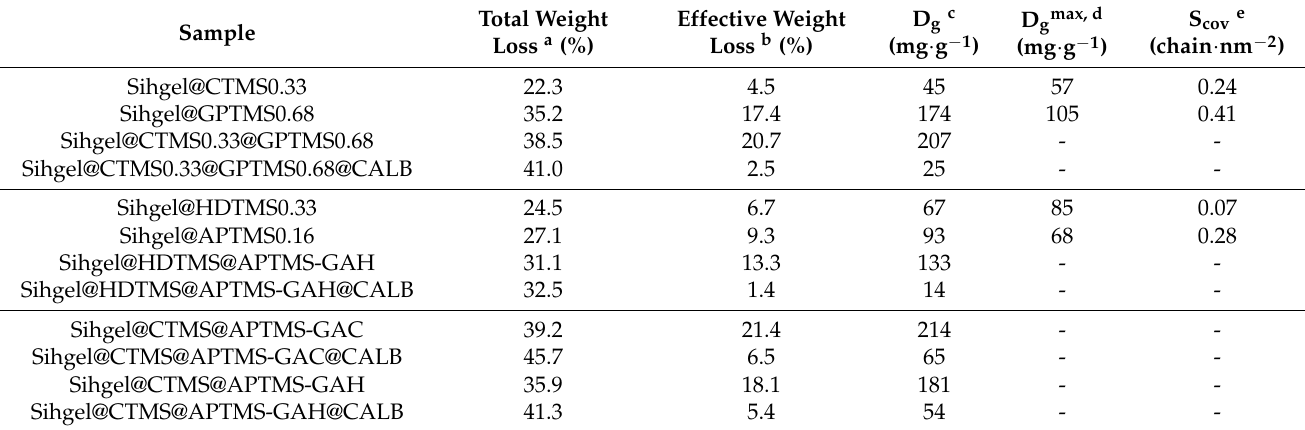
a Weight loss between 180 and 700 ◦ C, b weight loss corrected by the decomposition profile of sol-gel silica before surface functionalization, c grafting density of functional groups between 180 and 700 ◦ C, d maximum grafting density determined from Equation (2) (see Experimental part), e surface coverage determined from Equation (1) (see Experimental